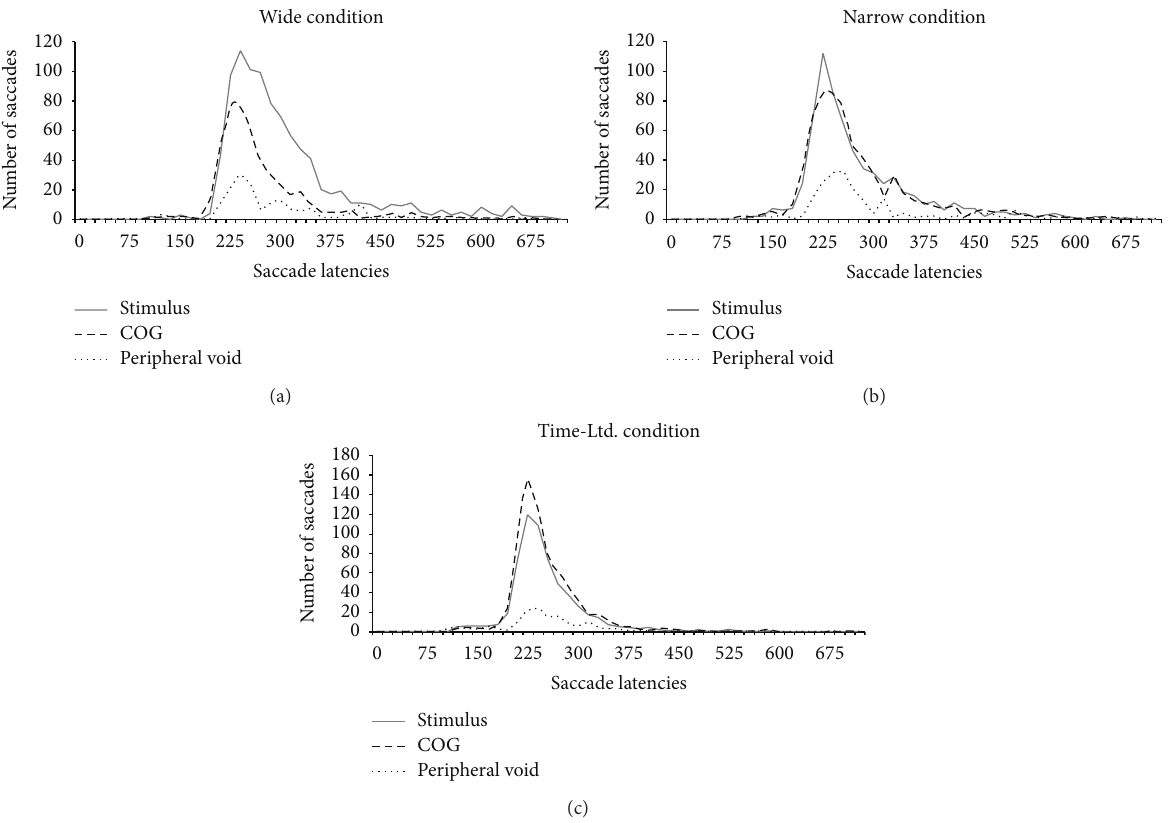
Figure5:Fixationsasafunctionofsaccadelatency.Numberoffixationsonastimulus,centralvoidregion(COG),orperipheralvoidregionas a function of saccadic latency, depicted separately for the wide and narrow spacing conditions and the time-limited narrow spacing condition. with unfamiliar and abstract stimulus materials.